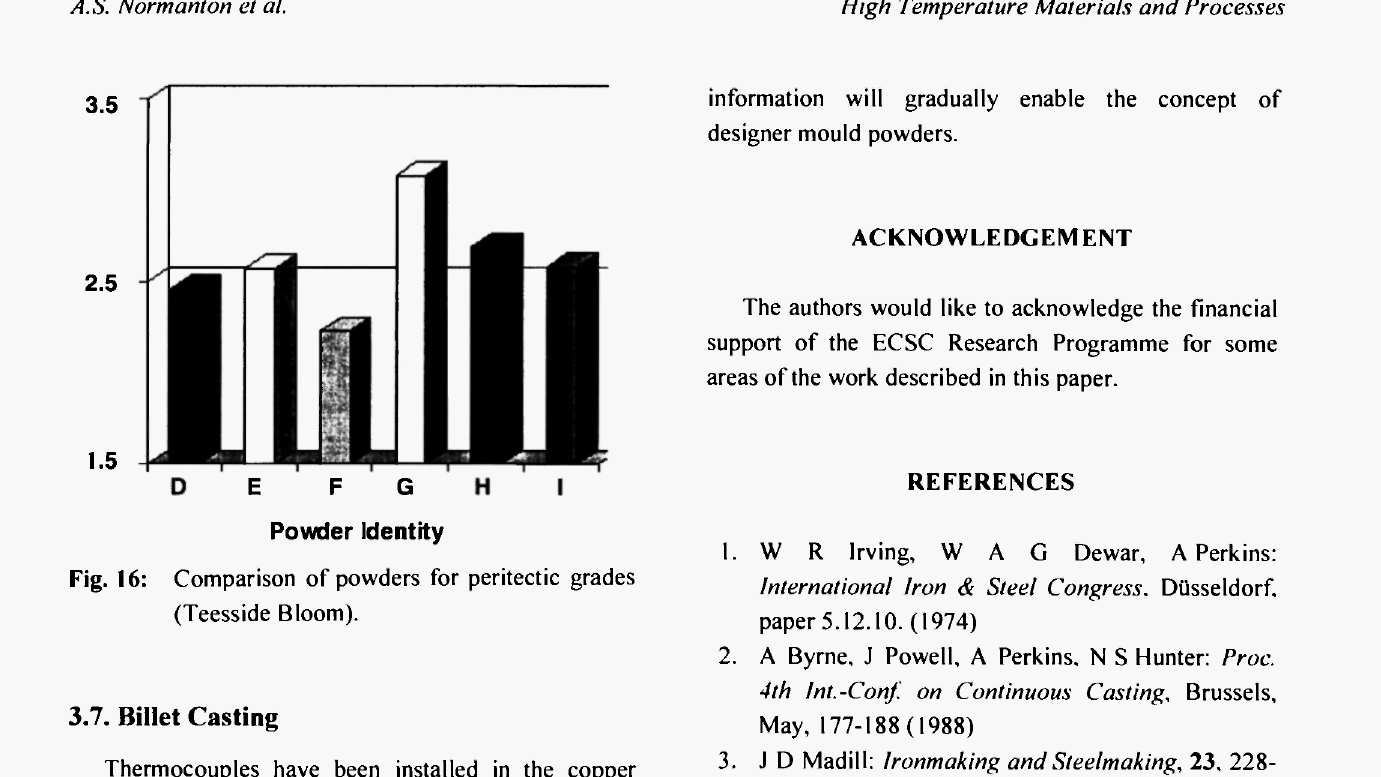
Fig. 16: Comparison of powders for peritectic grades (Teesside